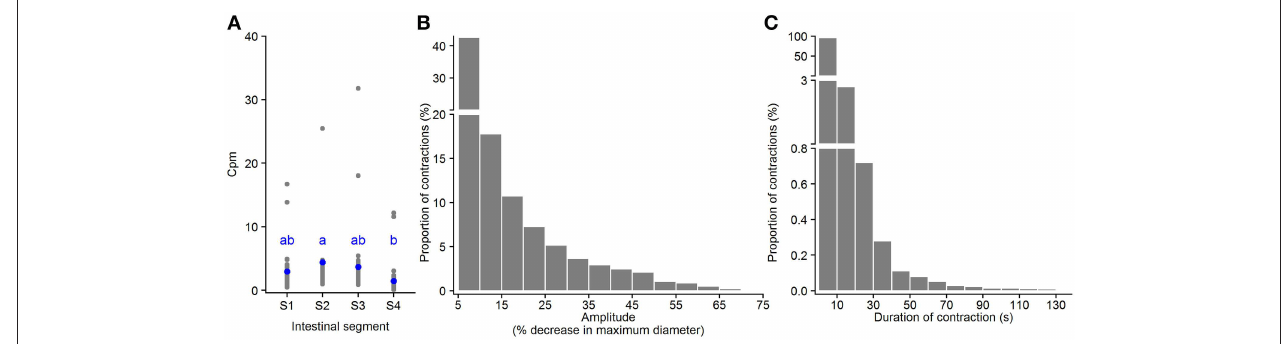
FIGURE 5 | Motility parameters for standing contractions in intestine of ballan wrasse juveniles. (A) Frequency of standing contractions (contractions per min. per mm gut length, cpm) in the four intestinal segments (gray dots for individual values and blue dots for mean value calculated from 21 fish); letters denote difference between segments (ANOVA, Tukey post-hoc test). (B) Amplitude of standing contractions was converted from mm to a relative value (%) in relation to the maximum diameter of the intestinal position where the contraction occurred. (C) Duration of standing contractions. (B,C) present histogram of data that was pooled from 21 fish. S1–S4, Segments 1–4 of the ballan wrasse